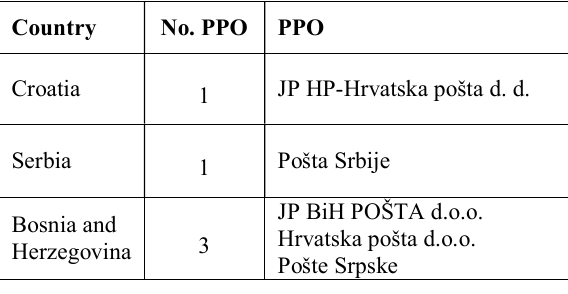
Table 1. Public postal operators by analyzed countries [18,19].